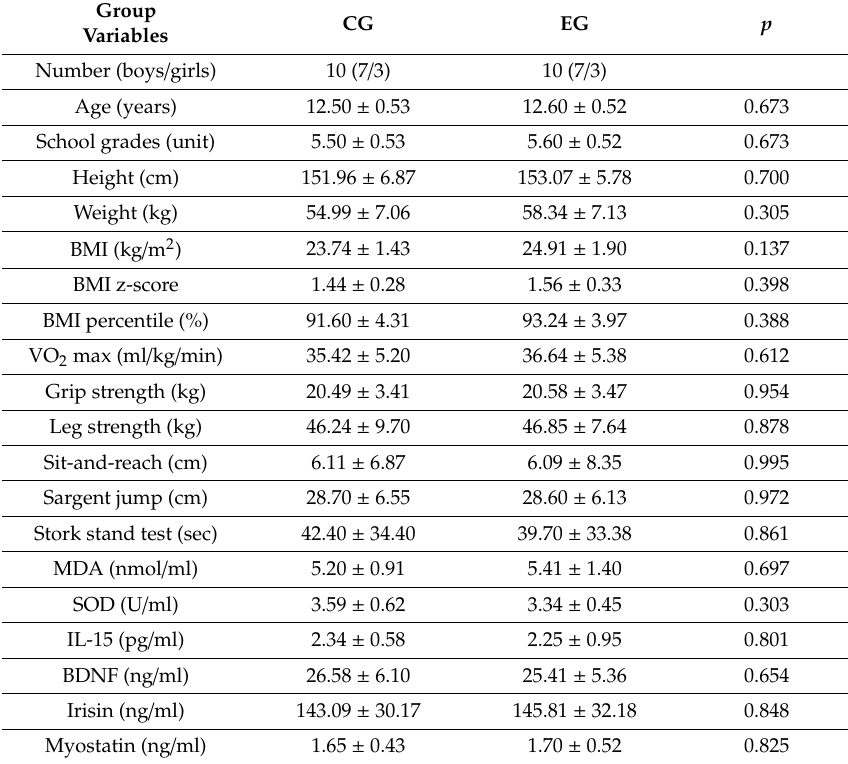
Table 1. Characteristics of the participants at